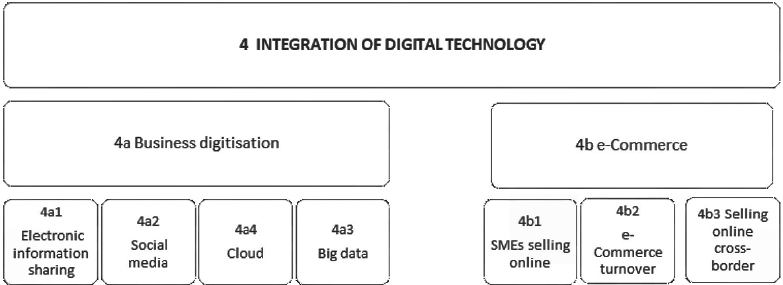
Figure 4. Use of Internet services indicators – a part of DESI